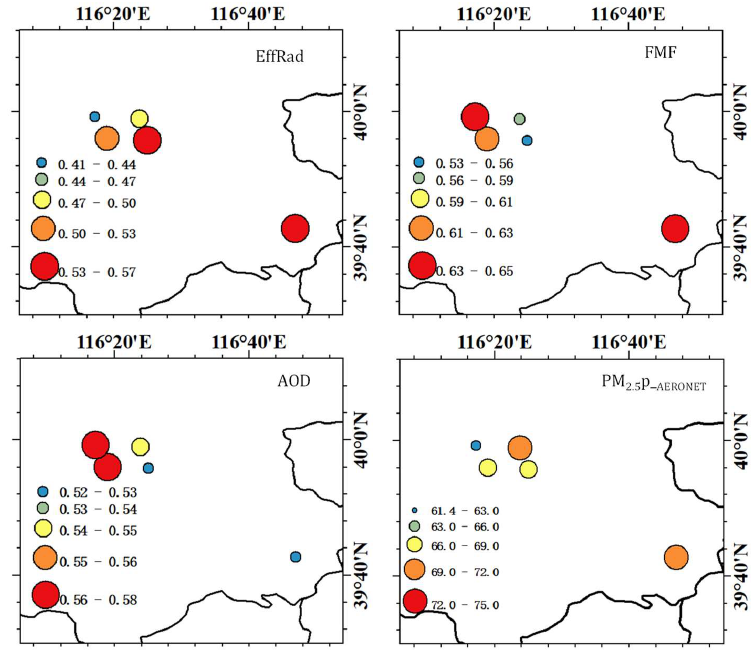
Figure 14. The annually averaged AERONET EffRad, FMF, AOD, and SPSEMCA retrieved PM 2.5 of five PM 2.5 monitoring stations in 2016.